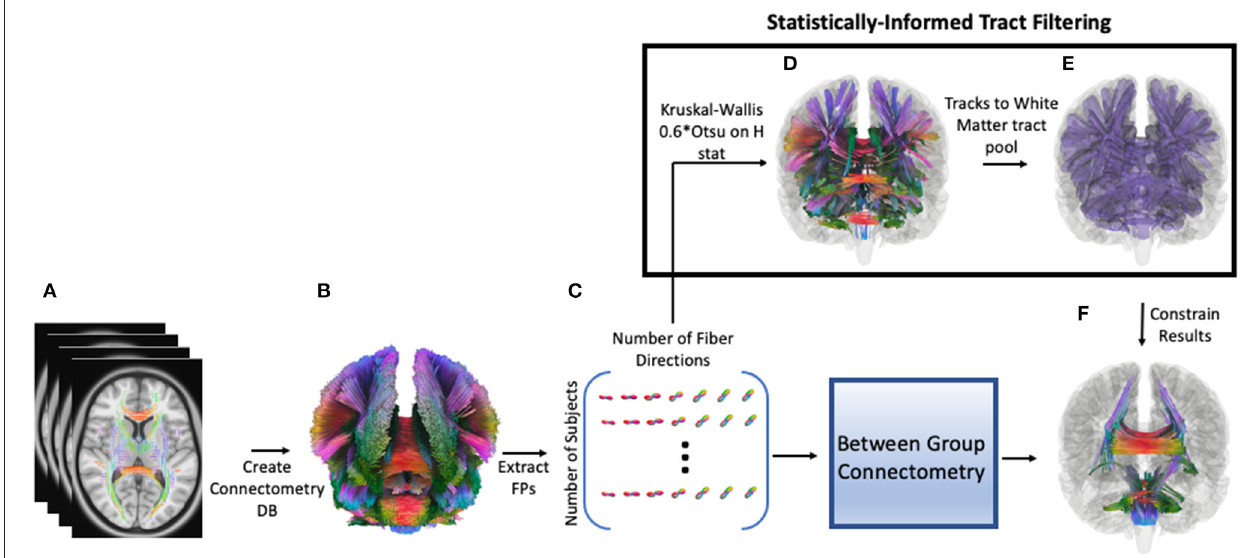
FIGURE 1 | Pipeline for analysis. First, preprocessed diffusion data for each participant is reconstructed using QSDR, followed by creating a population template and subsequent connectometry database (DB, A,B ). Then individual “local connectomes”–i.e., individual connectome fingerprints (FP)–are extracted from this database as a matrix, size of number of subjects by (voxels x local fiber directions, C ). Each column represents the SDF value for an individual local fiber direction, which is used in a Kruskal-Wallis test (non-parametric ANOVA) to generate an H-statistic for that direction. A threshold is calculated for these H statistics (0.6*Otsu’s threshold) and surviving fiber directions are clustered (20 voxels) and converted into a region of interest (ROI); the ROI is inverted so that this inverted mask can be used a terminative mask to generate a tract pool of tracts that survived the Kruskal-Wallis thresholding (D) . In other words, any track that terminates outside of the original ROI is excluded. These tract segments are converted to an ROI (statistically-informed tract filtering show in E ) and used to filter the results from between-group connectometry analysis (F)